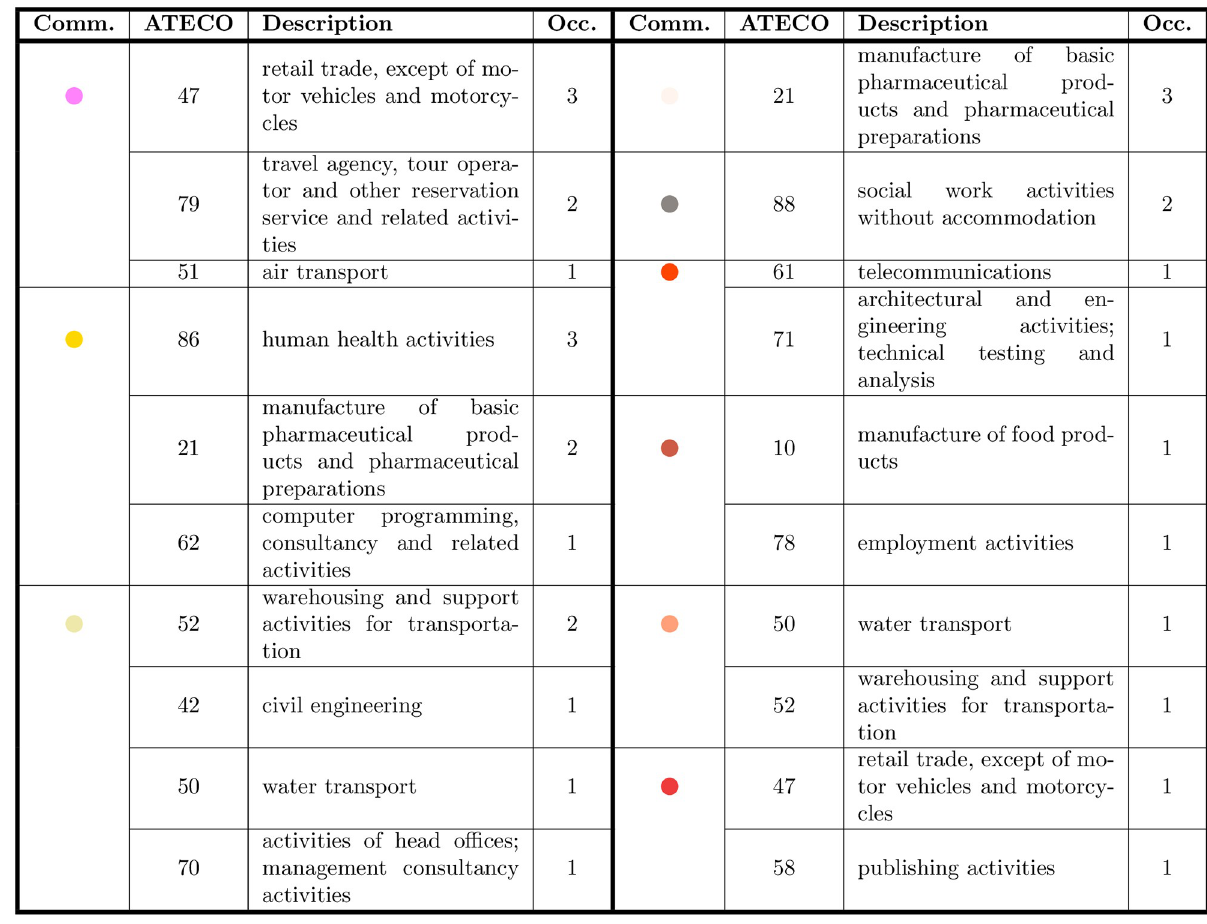
Fig 6. ATECO codes of the accounts involved in the various communities in the validated network of Fig 2, 2/2.